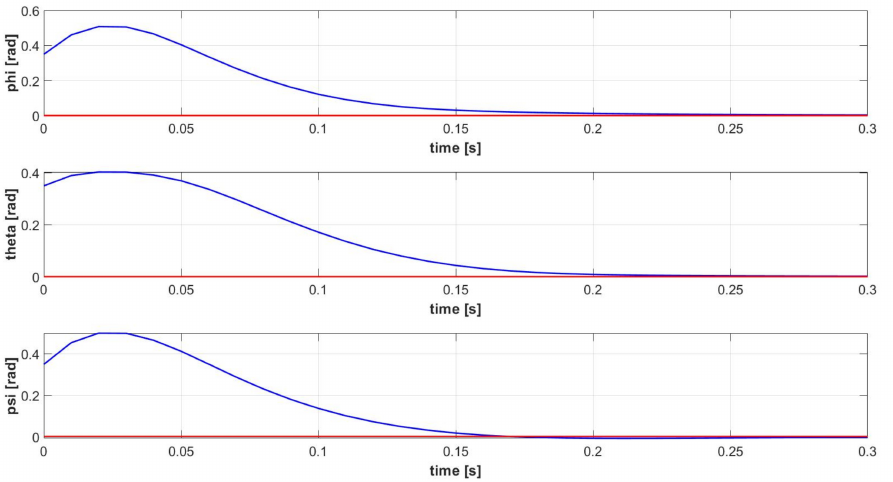
Figure 7. Euler angles signals [ φ ( t ) , ϑ ( t ) , ψ ( t ) ] of the controlled attitude system (blue): SMC-based Attitude Stabilizer